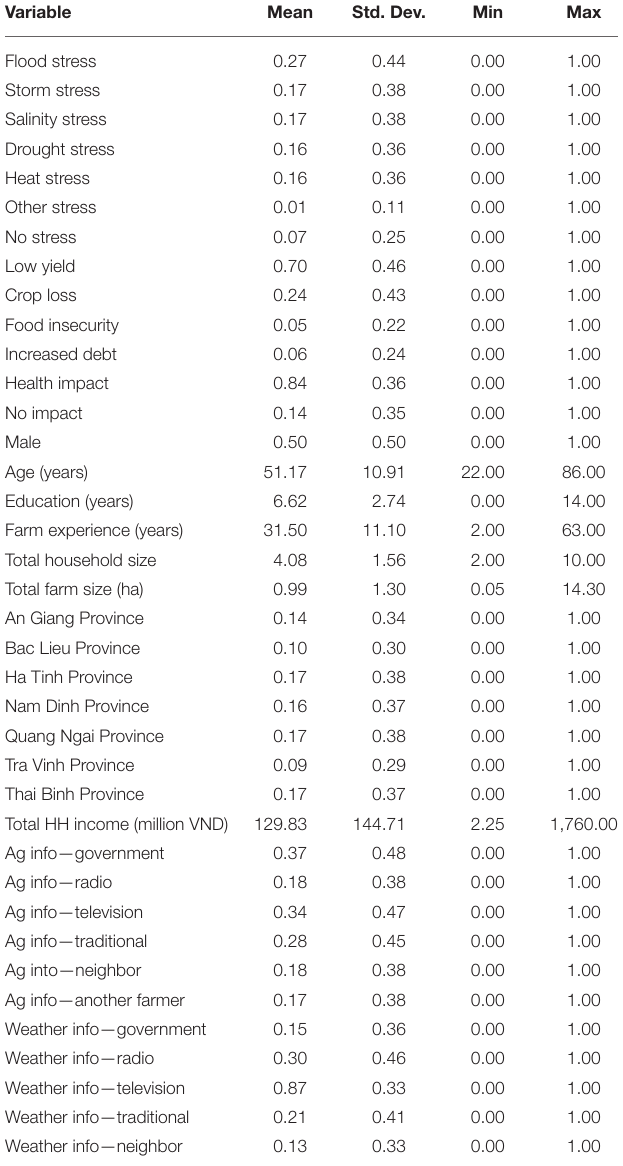
TABLE 1 | Summary statistics of independent variables.